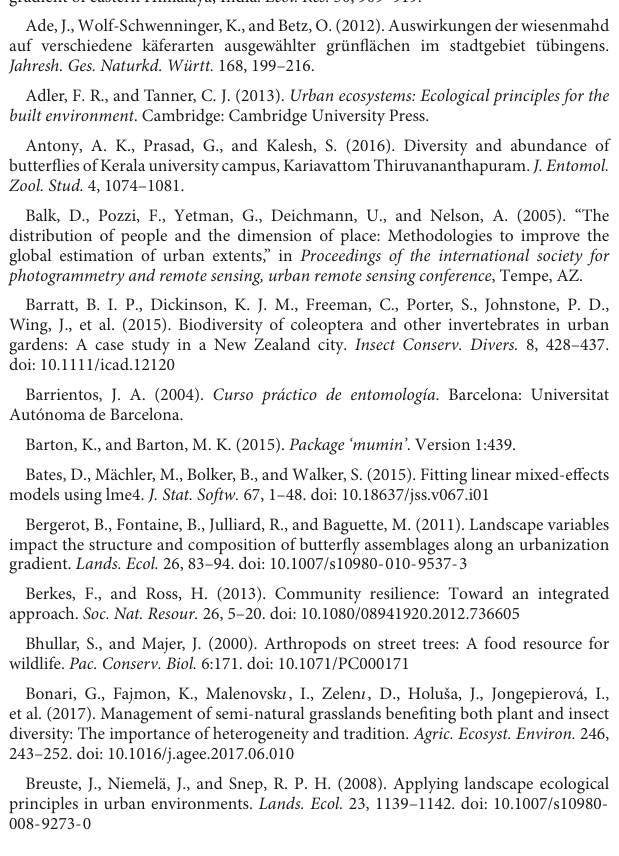
SUPPLEMENTARYFIGURE1 Species accumulation curves of the sample coverage of the study for (A) diurnal Lepidoptera, (B) ground-dwelling Coleoptera families and (C) ground-dwelling Coleoptera morphospecies in university campuses and other urban areas. Colored bands represent confidence intervals. SUPPLEMENTARYFIGURE2 Taxonomic diversity in each campus/non-campus pair: (A) Lepidoptera species richness ( q = 0), (B) Lepidoptera common species ( q = 1),